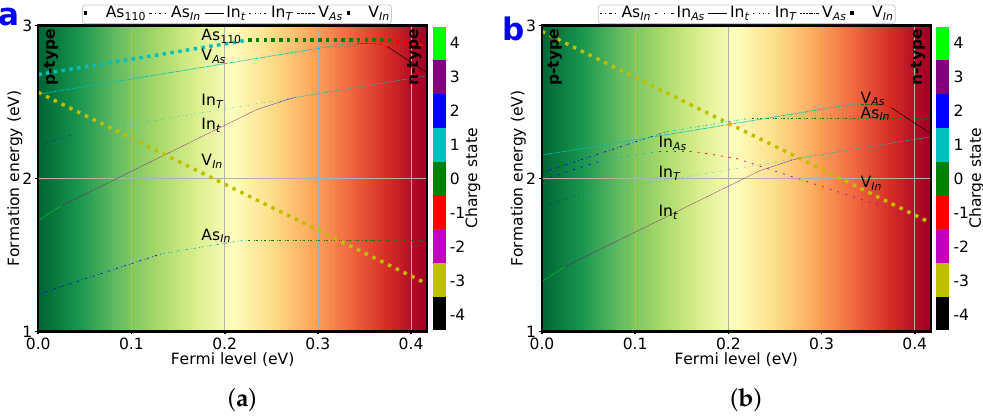
Figure 8. Six lowest defect formation energies in zb -InAs as functions of E F in the ( a ) As-rich and ( b ) In-rich environment with all possible charge states from − 4 to + 4 marked by corresponding